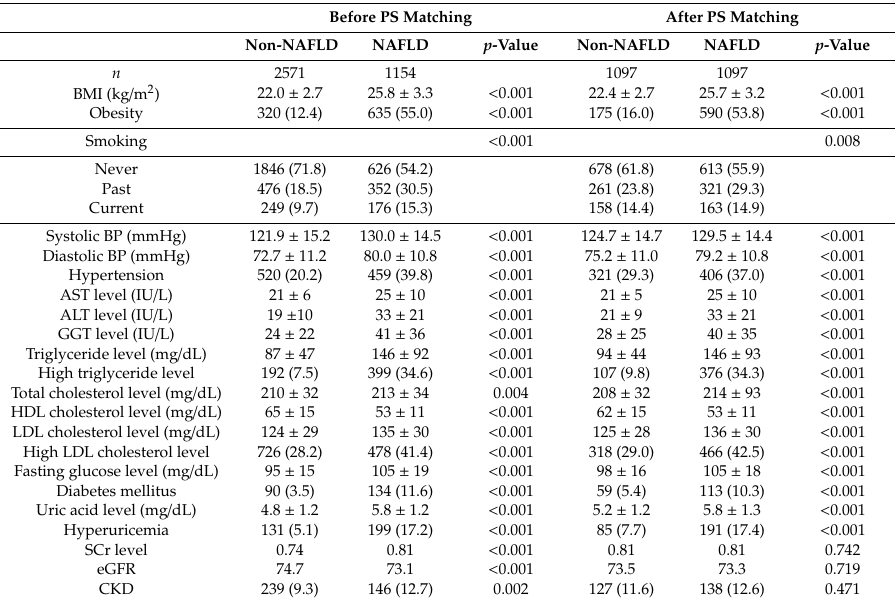
Table 2. Comparison of characteristics between subjects with and without NAFLD. Before PS Matching After PS Matching Non-NAFLD